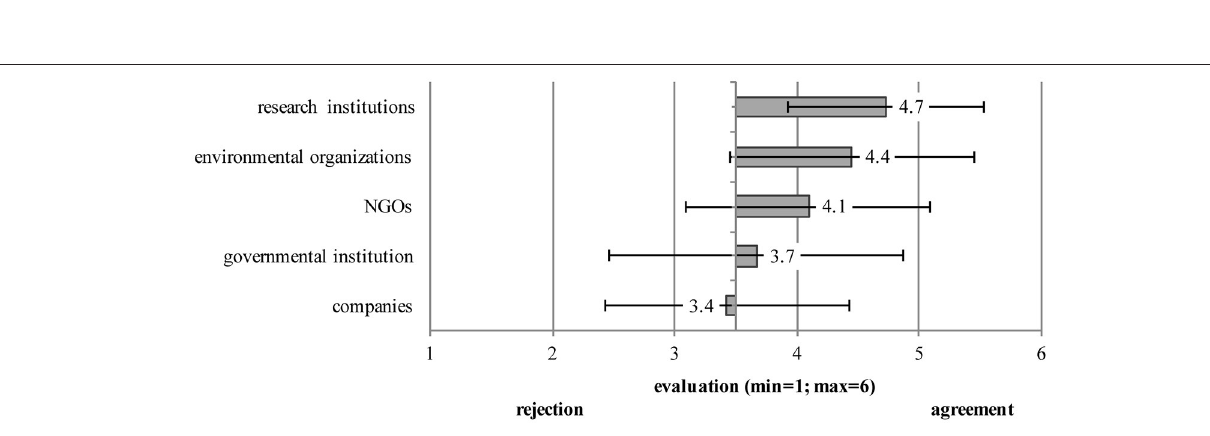
FIGURE 1 | Text and illustration of the introduction concerning the CCU technology and CCU products.